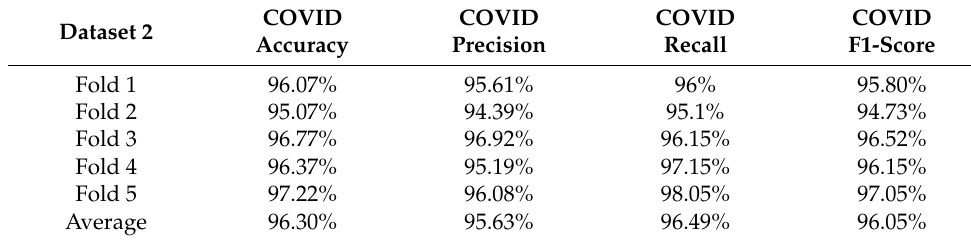
Table 7. COVID accuracy of dataset 2.